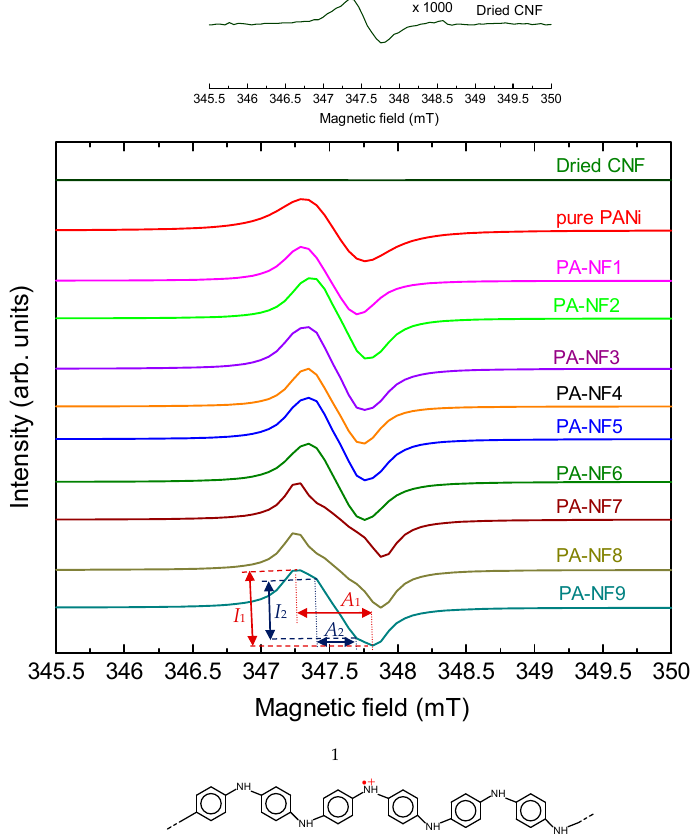
Figure 5. Electron spin resonance (ESR) spectra. ( Top ): Magnification (1000×) of the ESR signal of dried CNF. ( Bottom ): Polarons in PANI. Table 2. ESR results and electrical conductivity.